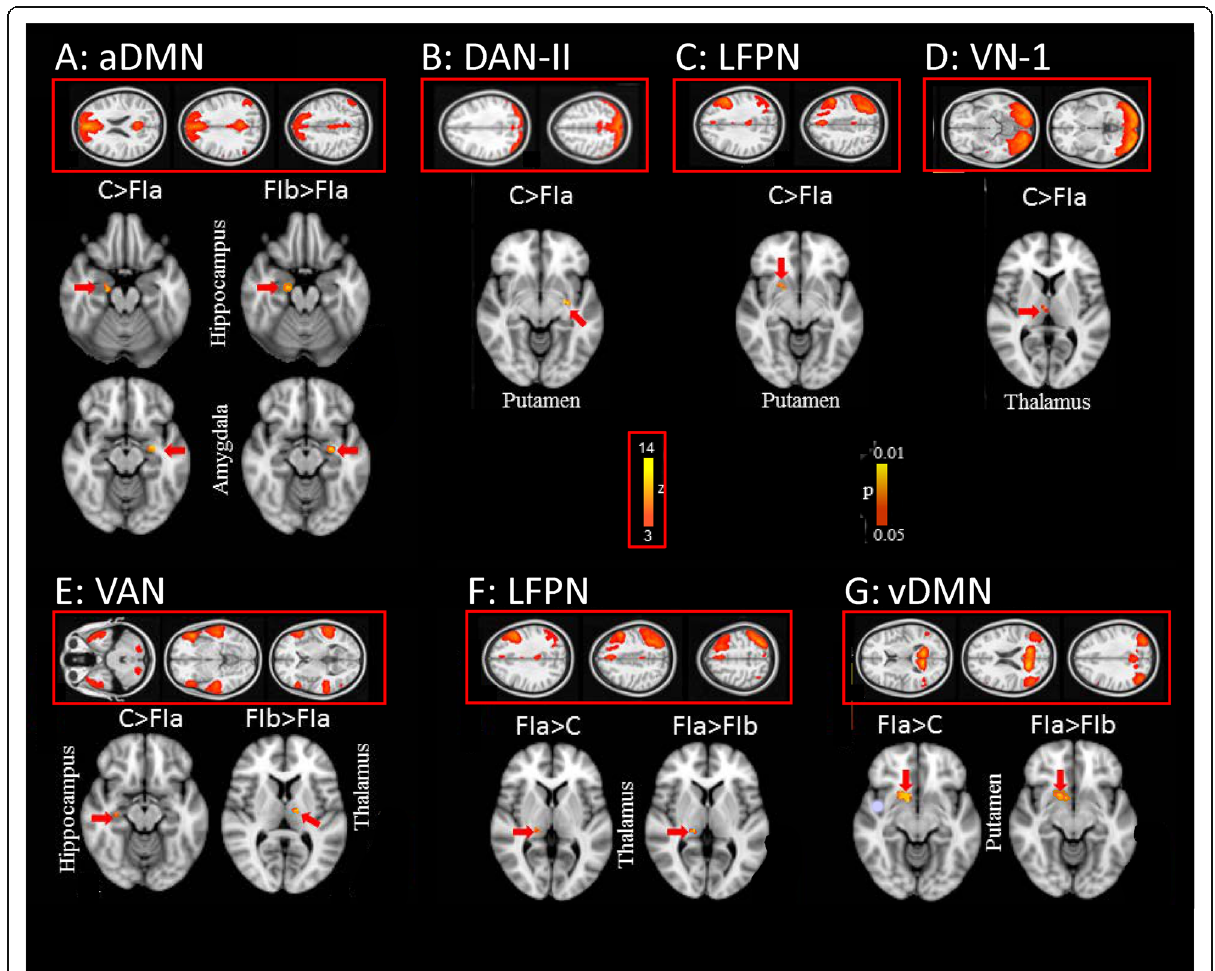
Fig. 3 Seed Based Correlation Analysis (SBCA) between selected subcortical areas (indicated by red arrows) and different neocortical networks. a anterior default mode network (aDMN); b dorsal attention network II (DAN-II); c / f left fronto-parietal network (LFPN); d visual network-I (VN-1); e ventral attention network; g ventral default mode network (vDMN). All data are FWE-corrected for multiple comparisons ( p < 0.05). C: Control group; FI.a: functional illiterates before training; FI.b: functional illiterates after training